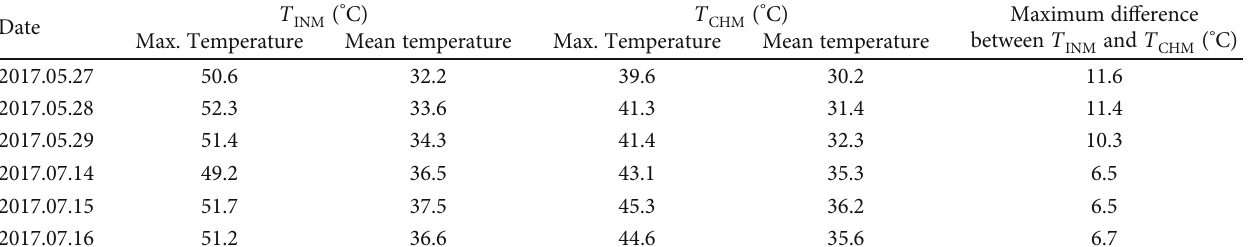
Table 8: Test results of the inner side temperatures of PV cell and passage temperatures in the middle position. ° C) T T INM ( Date